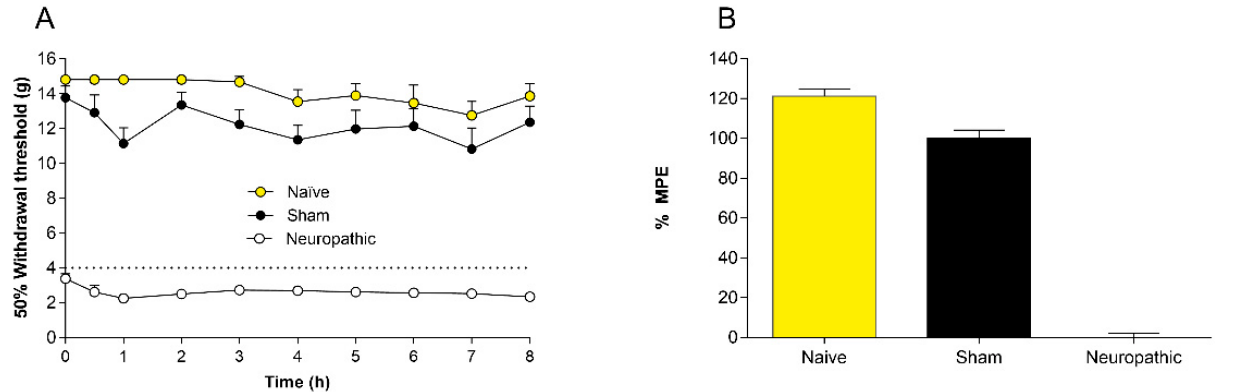
Figure 1. Mechanical allodynia induced by spinal nerve L5-L6 ligation. ( A ) Time courses of 50% hind paw withdrawal threshold in naïve (white circles), sham (black circles) or L5-L6 spinal nerve ligation-induced neuropathic (grey circles) rats. ( B ) Percentage of maximum effect possible (%MPE) calculated from the time courses with the different groups. Data represent the mean ± SEM of six animals per group.